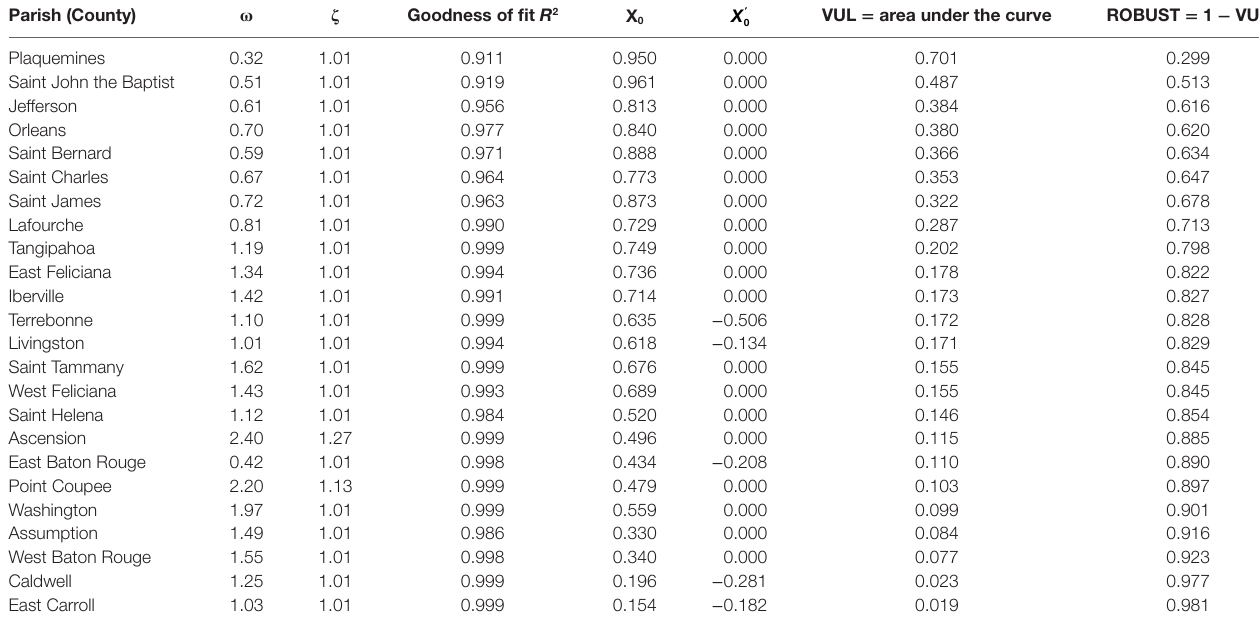
TaBle 3 | Frequency and damping parameters for selected parishes in Louisiana for Hurricane Isaac. Parish (county)